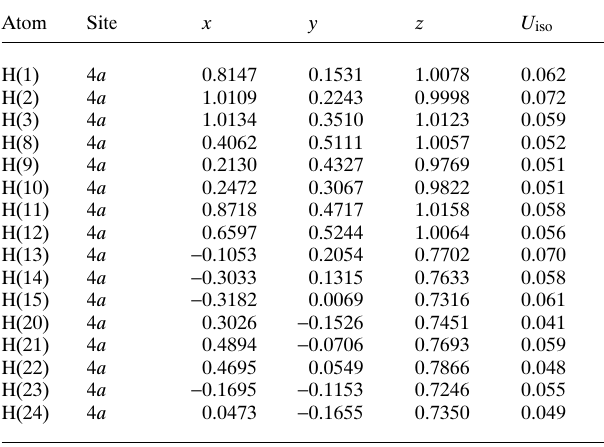
Table 2. Atomic coordinates and displacement parameters (in Å 2 )